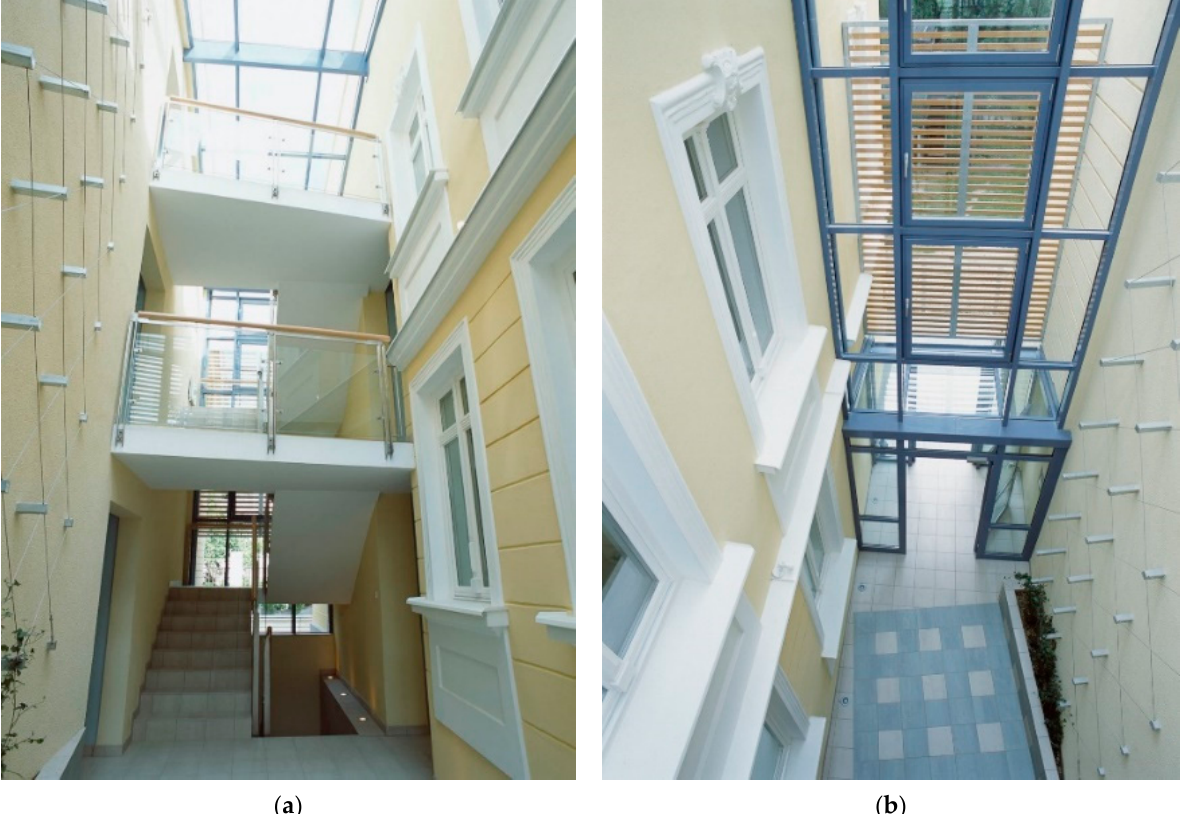
Figure 15. The glazed entrance hall of Willa Halina; ( a ) ground floor view; ( b ) view from the first floor. Source: FORT Taraszkiewicz Architekci.